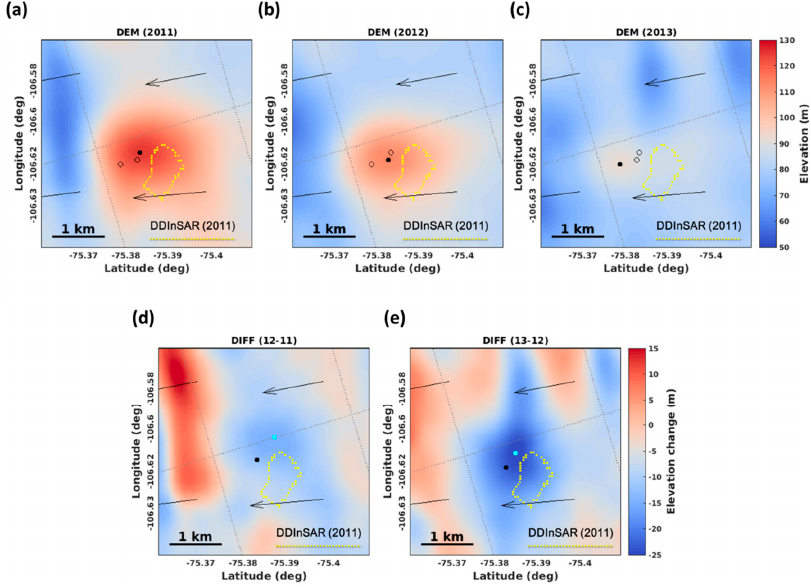
Figure 4. Detailed surface digital elevation models (DEMs) of the ice rumple from 2011–2013, showing its yearly surface deformation and surface velocity (arrows): ( a – c ) Location of maximum elevation in each of the three years (filled circles indicate the peak in that year); ( d , e ) Deformation maps for the periods 2011–2012 and 2012–2013 (later year subtracted from earlier year) where cyan circles indicate maximum surface depression and black circles indicate maximum elevation in each reference period. The InSAR grounding line in 2011 is plotted by the yellow dotted line [13,15].